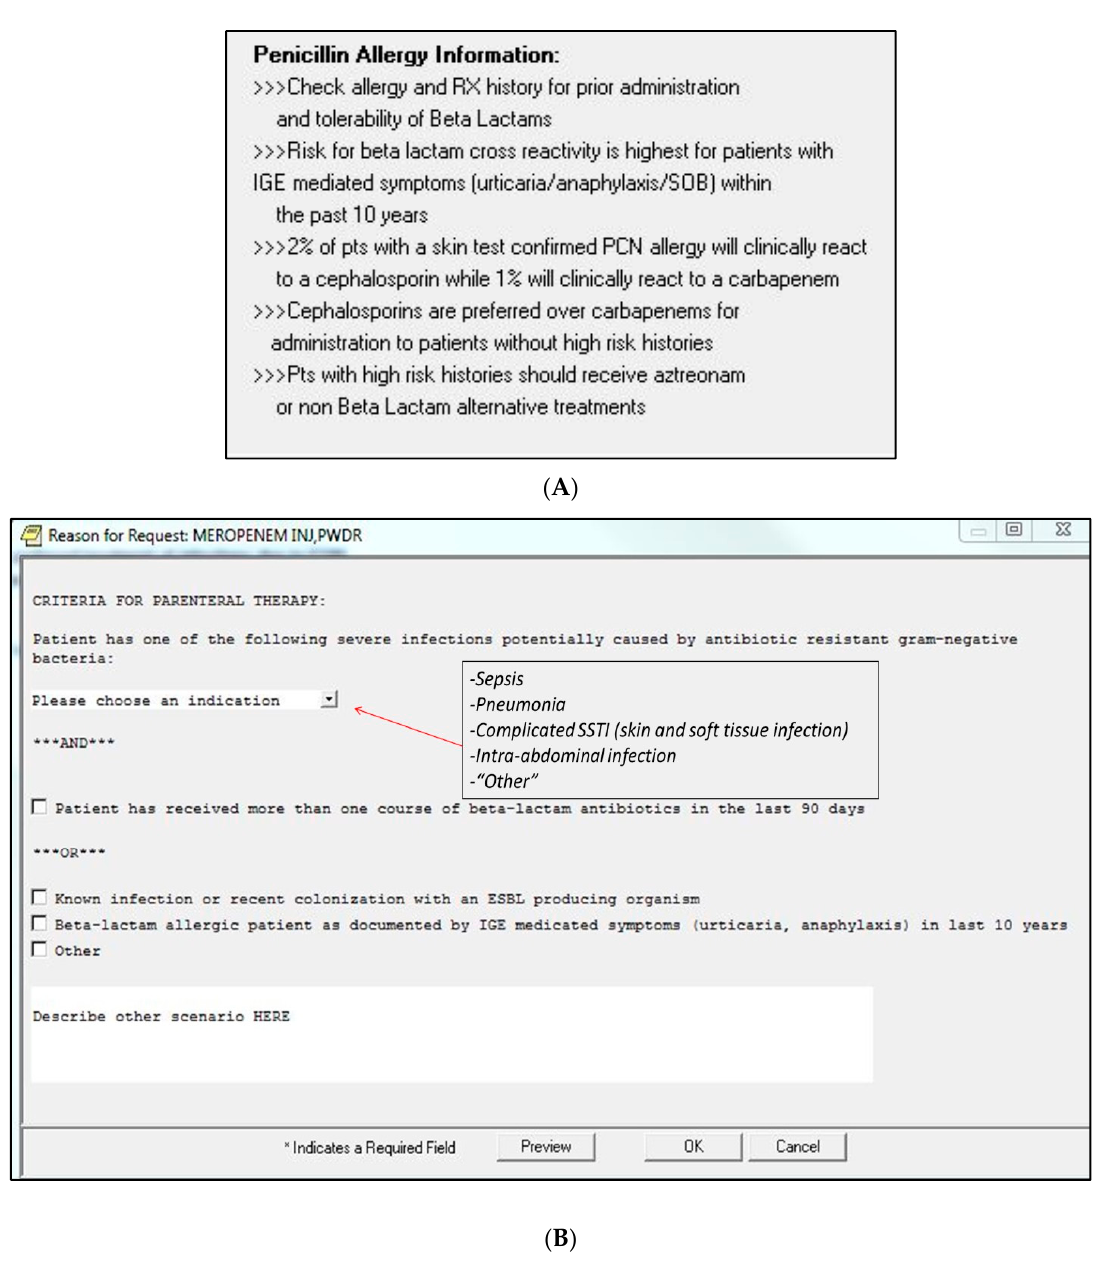
Figure 2. ( A ) Computerized decision support system—information regarding penicillin allergy cross- reactivity with cephalosporins and carbapenems; ( B ) Meropenem order prompt (providers